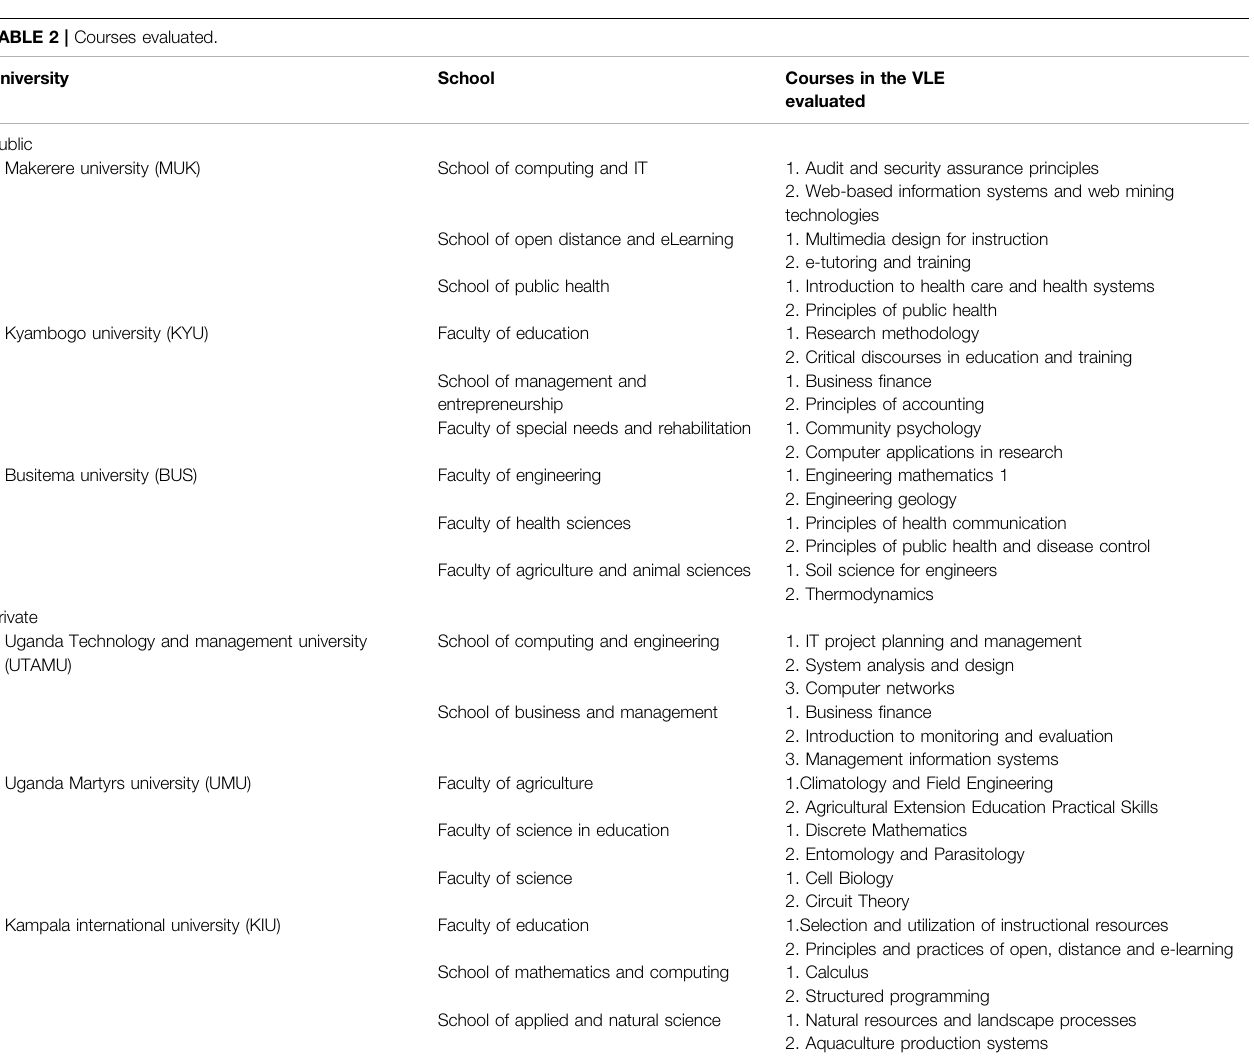
TABLE 2 | Courses